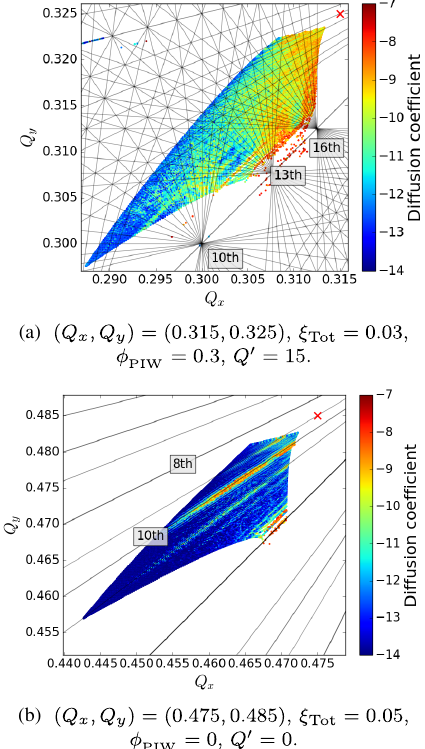
FIG. 11. FMAs illustrating activation of synchrobetatron res- onances at the alternative working points, related to the beam quality study in Fig. 10. Possible resonance lines up to the 16th order have been plotted on top of the tune footprint. A few labels were added to guide the